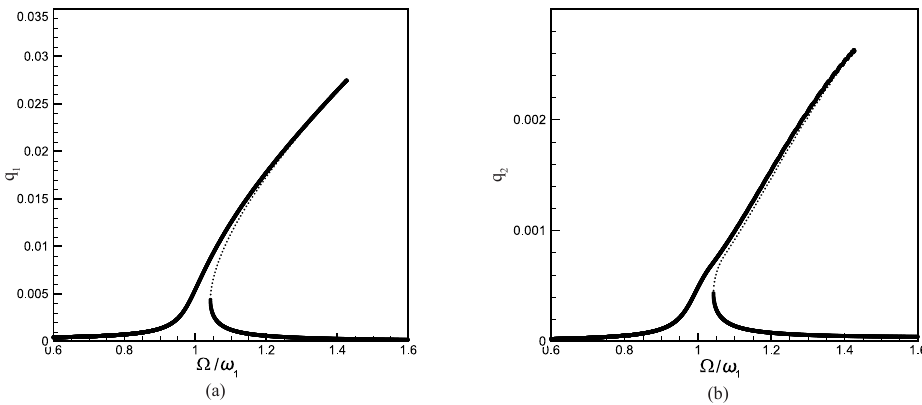
Fig. 2. The frequency response curve of the system with no internal resonances between the first two modes. Bold and dotted lines represent the stable and unstable solutions, respectively.